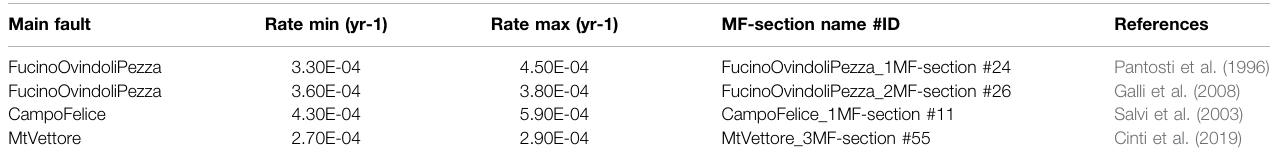
TABLE 2 | Rates of paleoseismic events deduced from published literature, used for comparison to synthetic earthquake rates ( Figure 6 ) estimated for corresponding MF- section (cf. Supplementary Table S3 for section properties and Figure 4 for location). Main